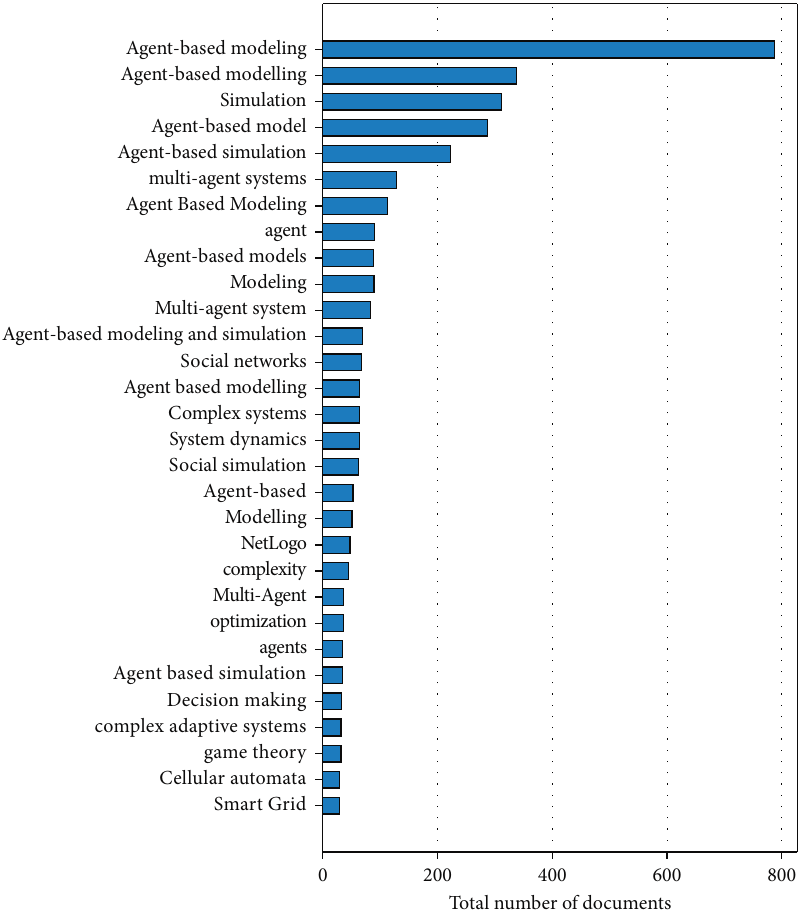
Figure 10: Bar chart of the top 30 authors’ keywords during